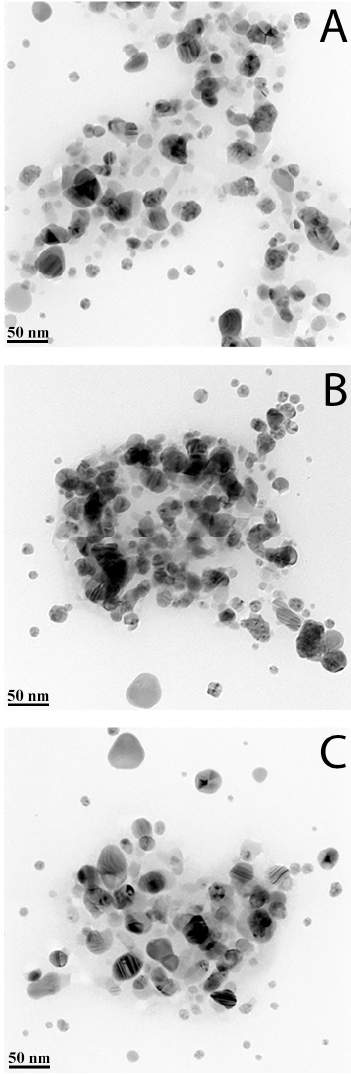
Figure 1. TEM images of AgNPs: ( A )—sample #1; ( B )—sample #2; ( C )—sample #3.